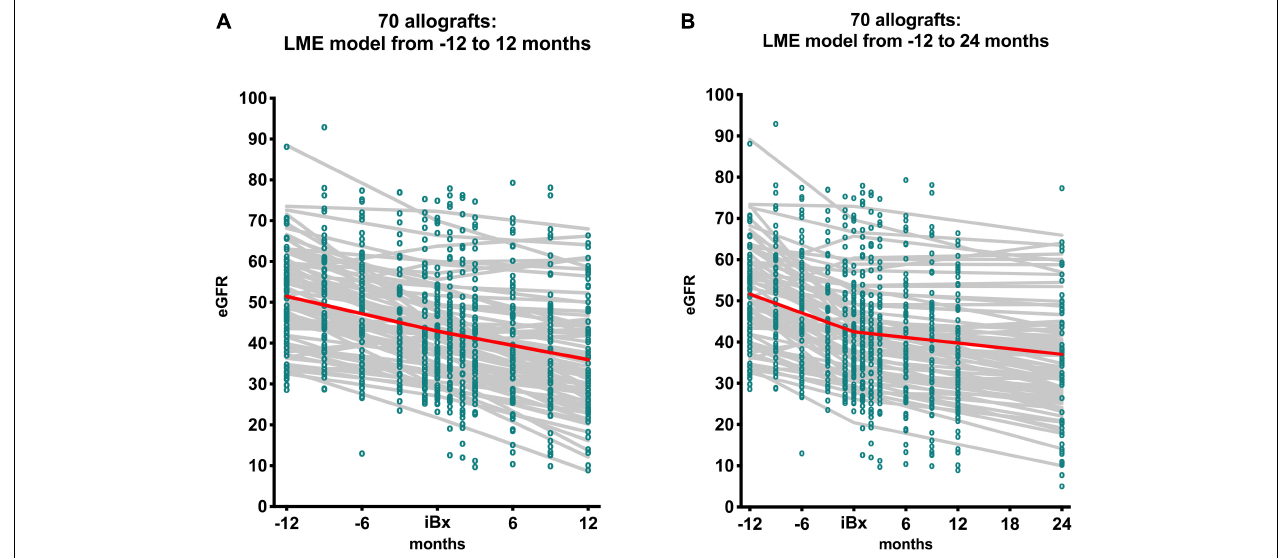
FIGURE 3 | It shows the single eGFR measurements (green dots), the individual eGFR trajectories (gray solid lines) as well as the overall trajectory (red solid line) of the total cohort ( N = 70). The linear mixed effects model (LME) was carried out over a course of 2 years (A) from − 12 to 12 months with intercept at time of iBx and over the course of 3 years (B) from − 12 to 24 months with intercept at the time of iBx. The shown overall trajectory is based on the fixed effects of the LME, whereas the individual trajectories also include the random effects.